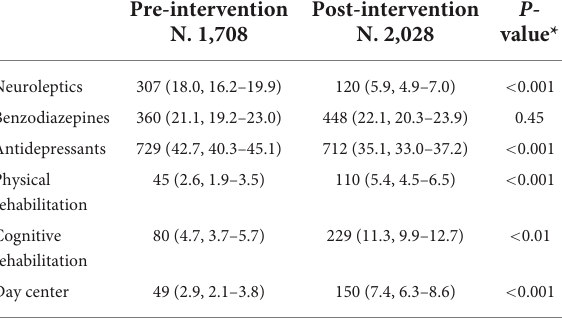
TABLE 4 Number (%, 95% CI) of patients with cognitive decline prescribed interventions, in the pre- and the post-intervention. Pre-intervention N.